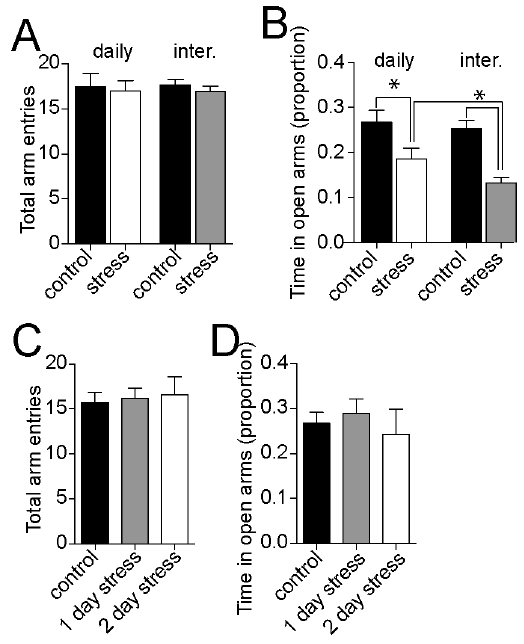
Figure 6. Interrupted restraint has greater impact on anxiety- like behavior. Exploration in the elevated plus maze (EPM) was measured. A) There was no significant difference in total arm entries between the 9 day daily and interrupted restraint groups, and their controls. B) Daily and interrupted restraint both led to decreased amount of time spent in the open arms. The effect of interrupted restraint stress on time in the open arms was significantly greater than the effects of daily restraint stress. C) There was no significant effect of one or two day stress exposure on total arm entries compared to controls. D) There was no significant effect of one or two day stress exposure on time in open arms compared to controls. * indicates p , 0.05 in post hoc tests after two-way